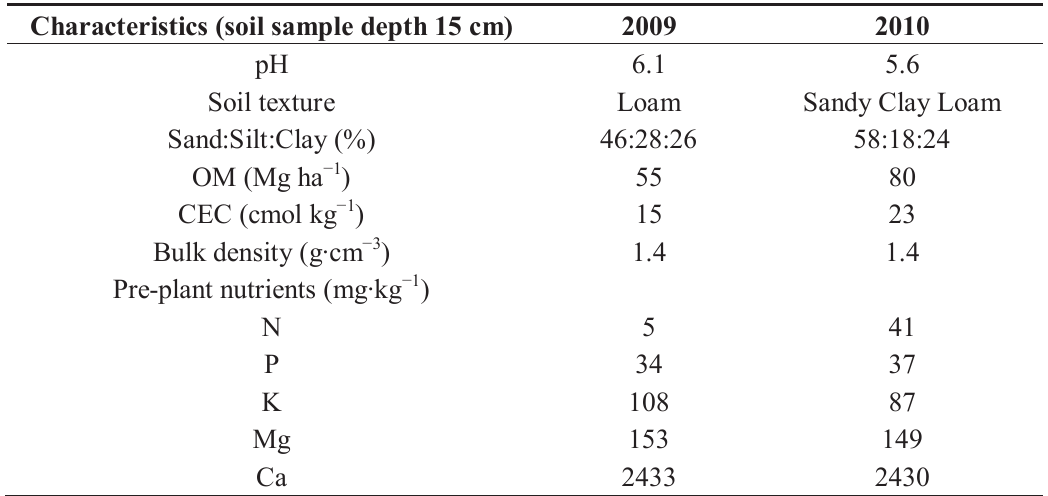
Table 1. Initial soil characteristics of the experimental sites prior to broccoli transplanting in 2009 and